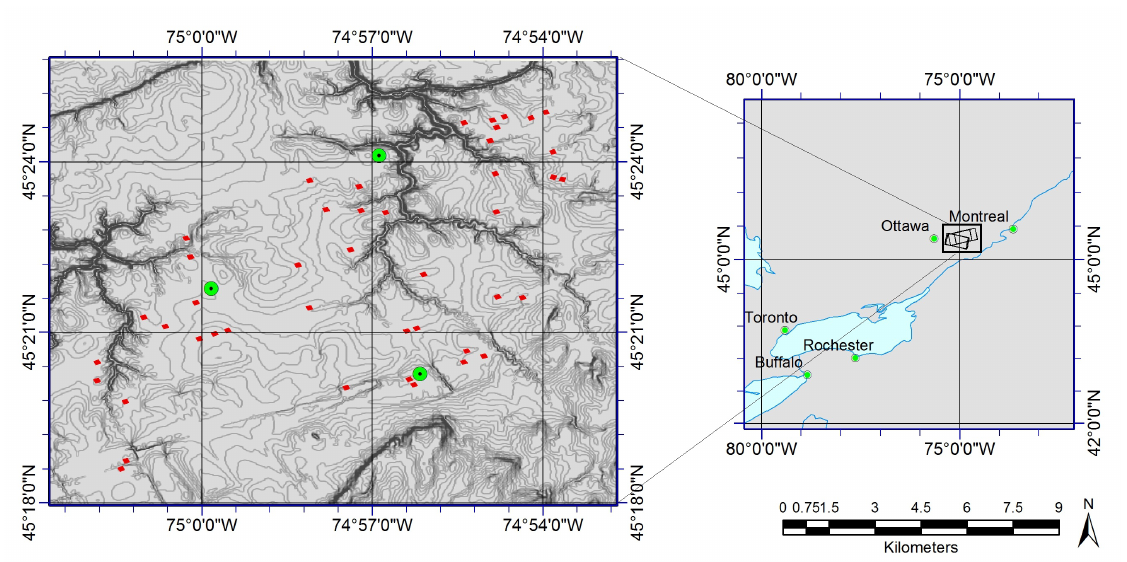
Figure 1. The Casselman study region/agricultural area situated in eastern Ontario, outside of Ottawa, Canada. RADARSAT-2 acquisition swaths are outlined, as well as location of large water bodies (The Great Lakes). In the zoomed map, soil moisture sampling locations (red points) are indicated, along with weather stations (green points). These points are super-imposed over contours of slope (digital elevation model, DEM). This map was generated using ArcMap 10.1